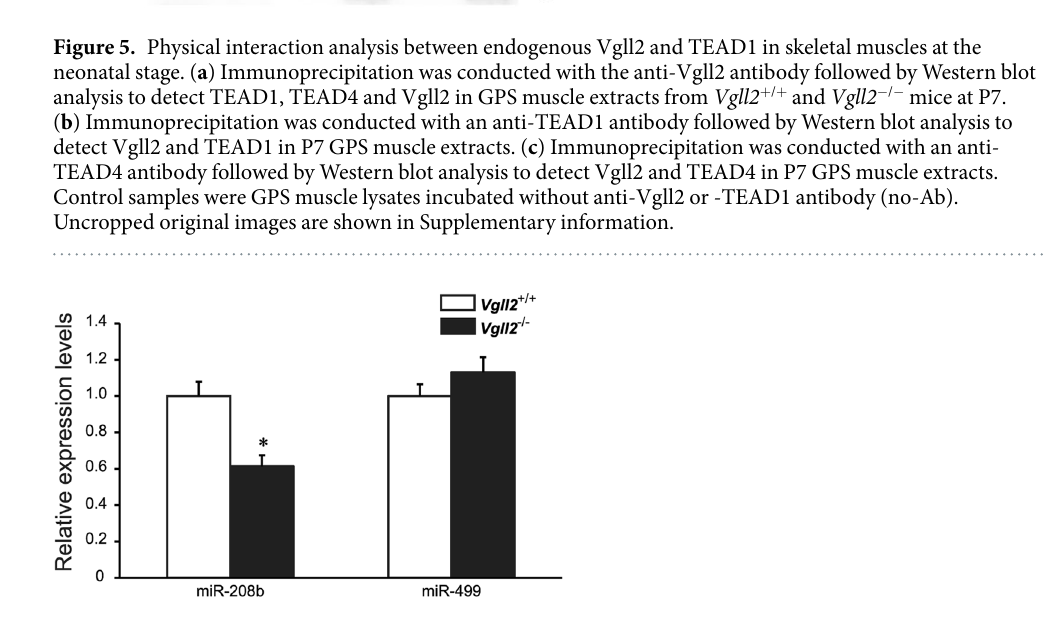
Figure 6. Expression analysis of miRNAs in the neonatal skeletal muscle. miR-208b and miR-499 expression levels in the GPS muscle from Vgll2 + / + and Vgll2 − / − mice at P7 (n = 8). For comparison, the expression level of these miRNAs in Vgll2 + / + mice was arbitrarily set at 1. Data are presented as mean ± SEM. * P < 0.05 vs . Vgll2 + / +